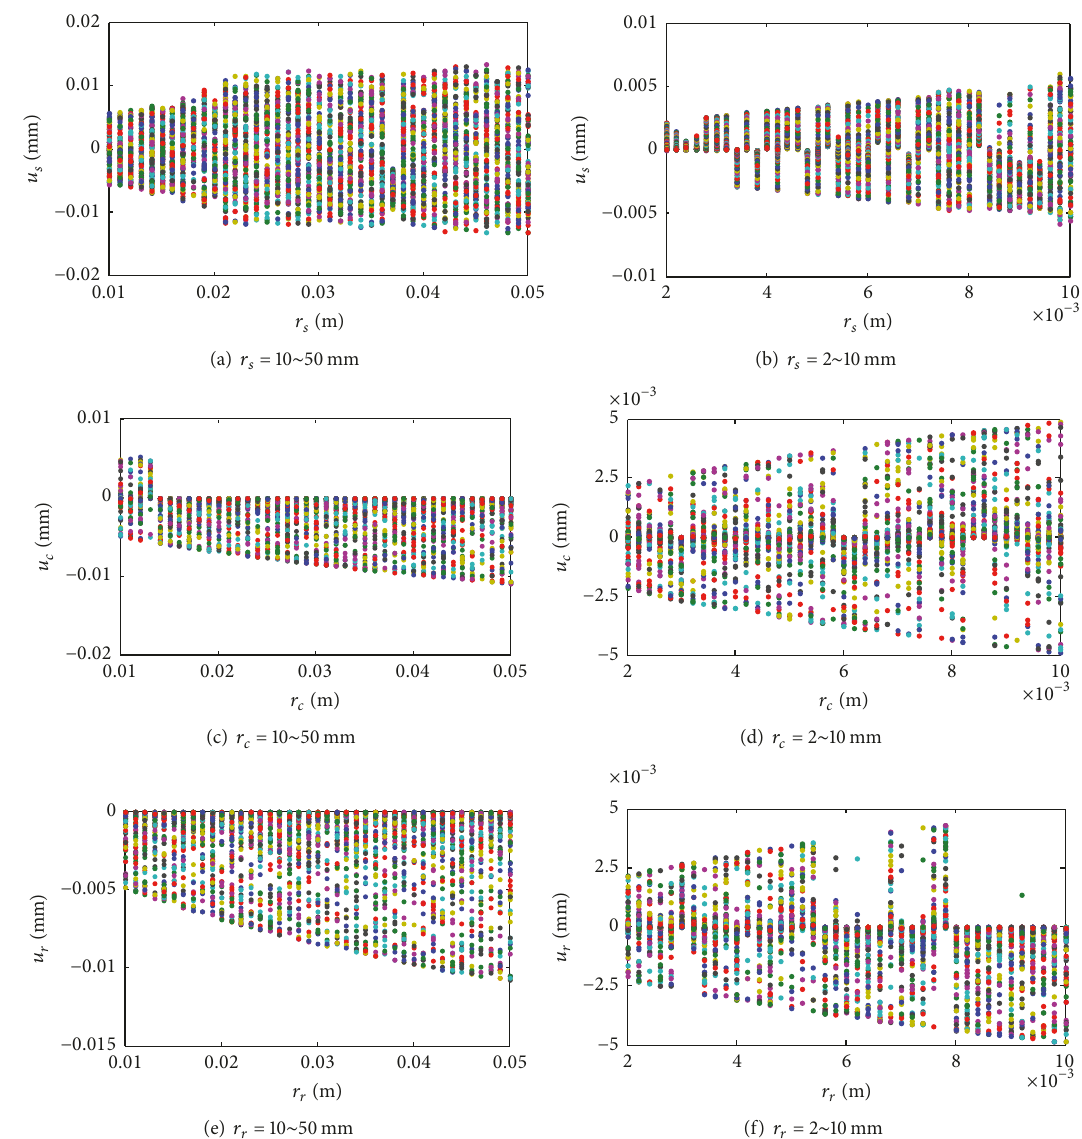
Figure 8: Bifurcation with theoretical